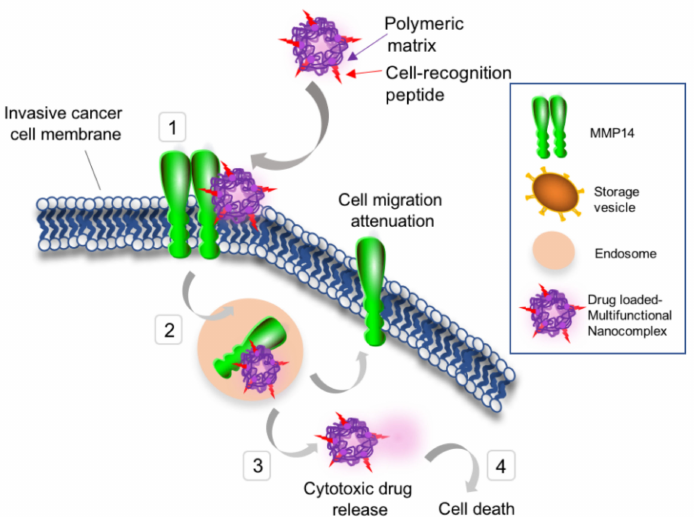
Figure 7. Proposed mechanism of action of the peptide-homing nanoparticles interacting with a cancer cell expressing MMP-14 at its surface. (1) NPs interact with the MMP14, via PEX domain, over- expressed at the membrane of invasive cancer cells; (2) NPs are internalized and routed to endosomes and intracellular vesicles; (3) NPs escape endosomal entrapment and encapsulated cytotoxic drug is released into the cytosol, which can lead to effective cell death